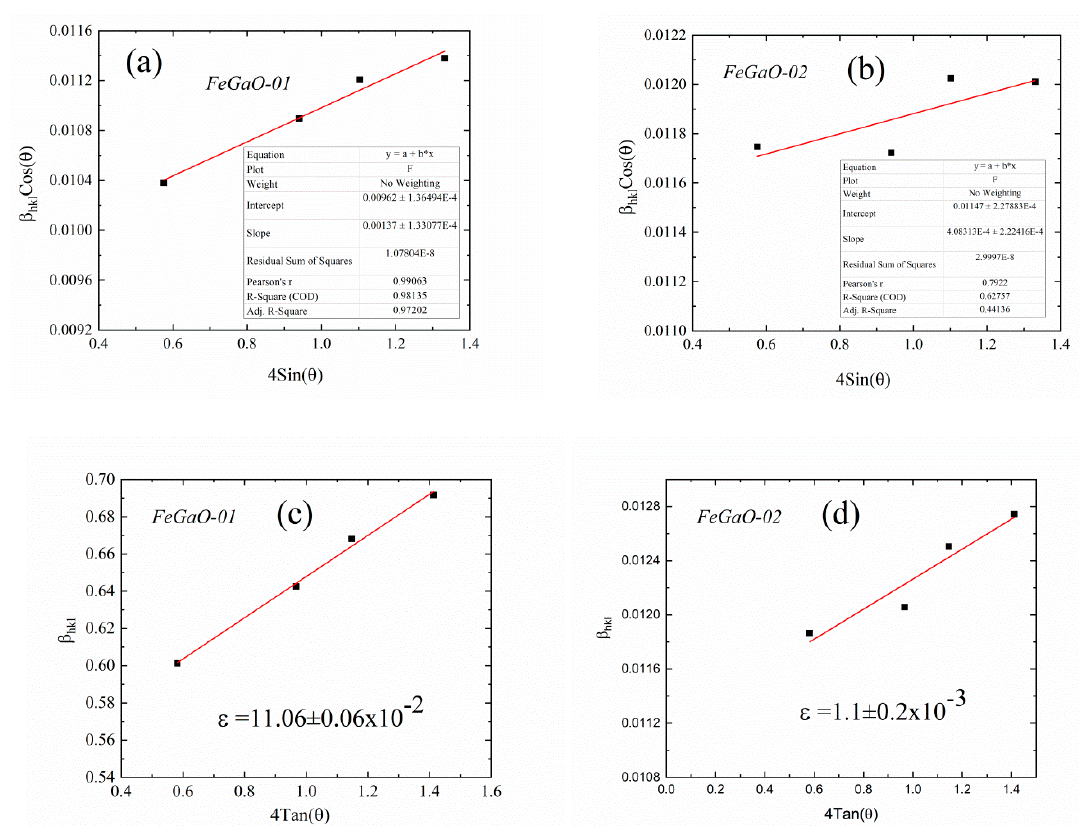
Figure 2. Fits to the uniform deformation model (UDM) for the samples to calculate the particle sizes Figure 2. Fits to Uniform Deformation Model (UDM) for the samples to calculate the particle sizes 165 of ( a ) FeGaO-01 and ( b ) FeGaO-02, and to calculate the microstrain with particles of ( c ) FeGaO-01 and of (a) FeGaO-01, (b) FeGaO-02 and to calculate the microstrain with particles of (c) FeGaO-01 , (d) 166 ( d ) FeGaO-02 FeGaO-02 . 167 Then, Rietveld refinements emloying FullProf sub program were performed to cal- 168 culate the crystal parameters of FeGaO-01 and FeGaO-02 samples. The crystal structure 169 was assumed as inverse spinel crystal formation. The inverse spinel crystal has the same 170